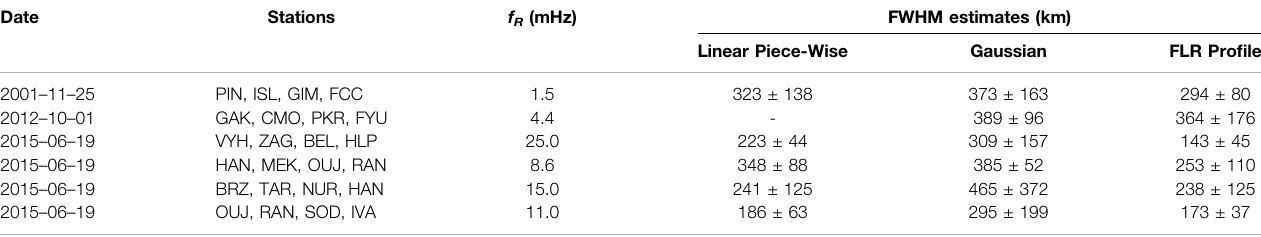
TABLE 2 | Latitudinal resonance width (2 ε , km) estimates using the FHWM method for each of the six selected intervals, with the linear piece-wise, Gaussian and Eq. 3 curve fi ts.